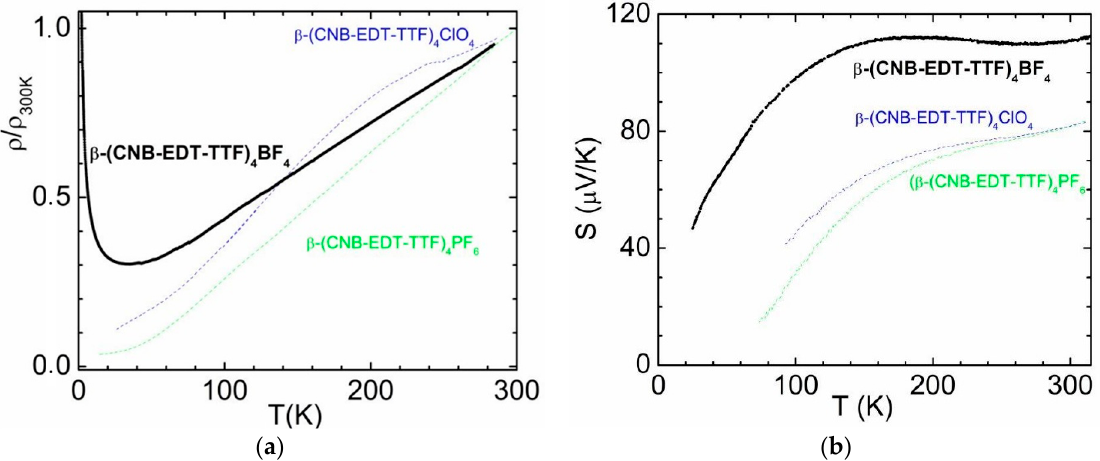
Figure 5. Temperature dependence of electrical resistivity ρ ( a ) and absolute thermoelectric power S , ( b ) of β ”-(CNB-EDT-TTF) 4 BF 4 single crystals compared with corresponding data for β ”-(CNB-EDT-TTF) 4 ClO 4 and β ”-(CNB-EDT-TTF) 4 PF 6 (thin lines, from reference [1]).